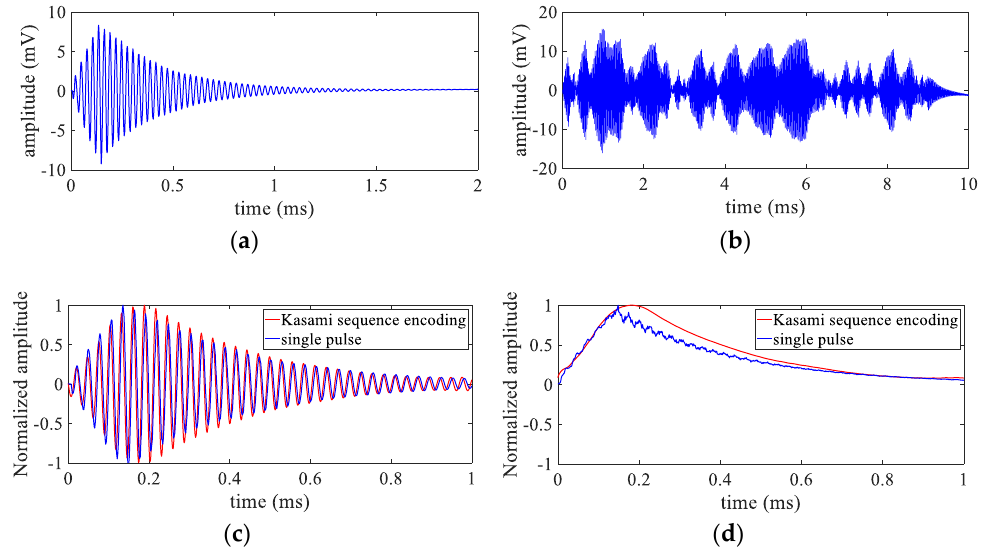
Figure 4. Comparison analysis of single pulse and Kasami sequence encoding excitation, ( a ) vibration signal under single pulse, ( b ) vibration signal under Kasami sequence encoding, ( c ) and ( d ) normalized waveform and envelope.